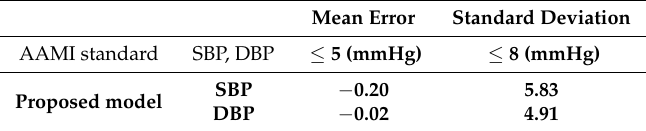
Table 8. Performance comparison with the AAMI standard.